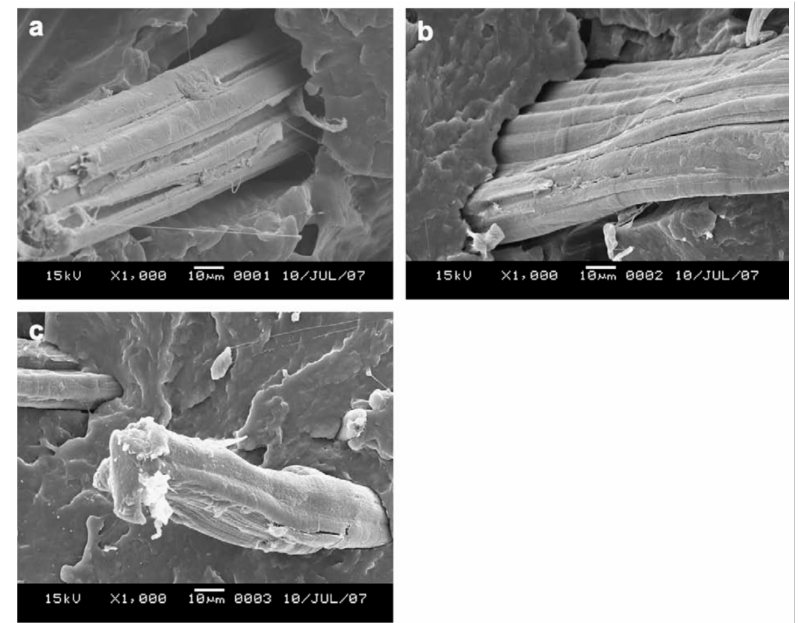
Figure 12. Surface morphology of ( a ) untreated jute/PBS, ( b ) alkali-treated jute fiber/PBS and